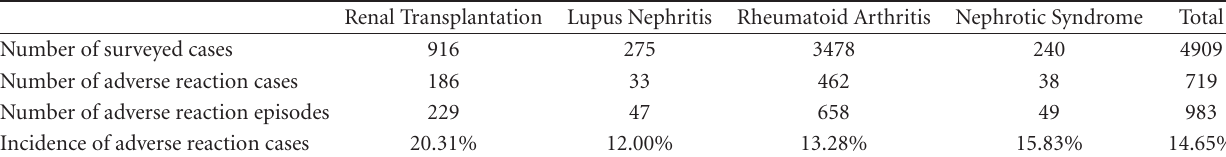
Table 5: Adverse reactions to